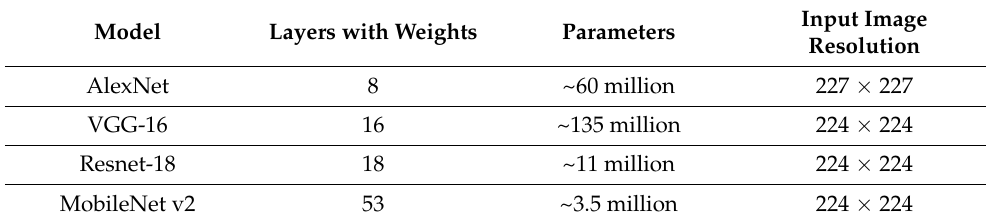
Table 1. Deep-learning CNN Image Classification Models Employed in This Study. Model Layers with Weights